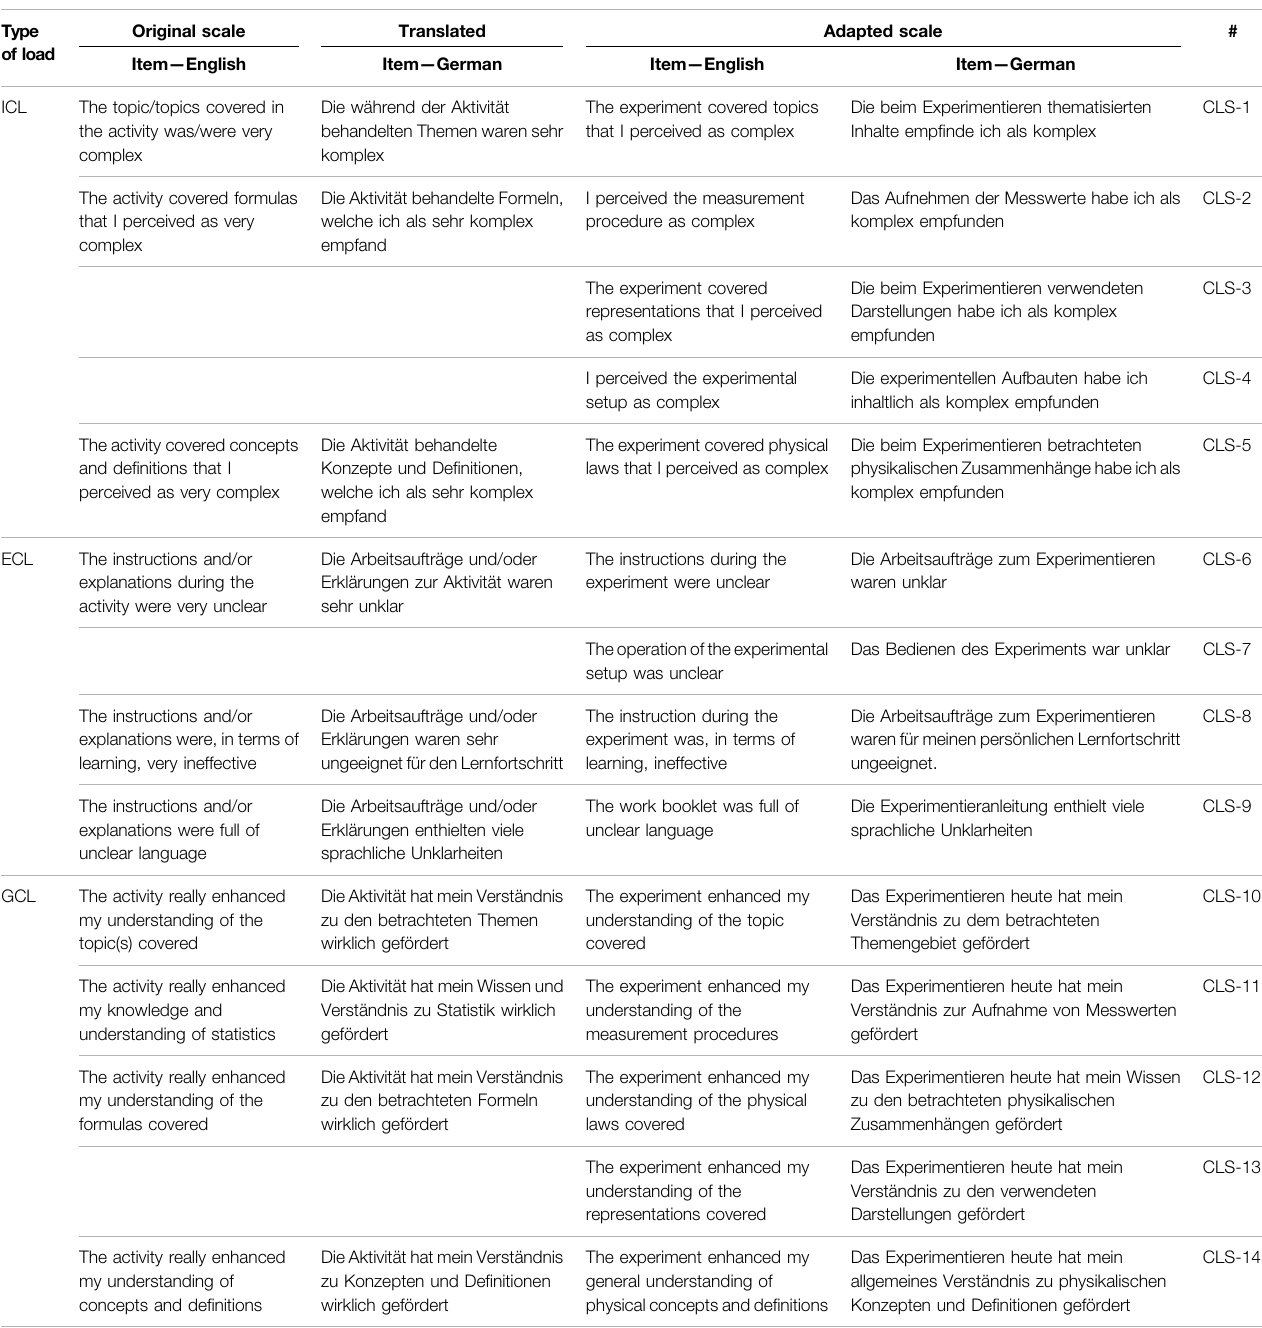
TABLE 2 | Original and adapted CLS, based on the work of Leppink et al. (2013). Type of